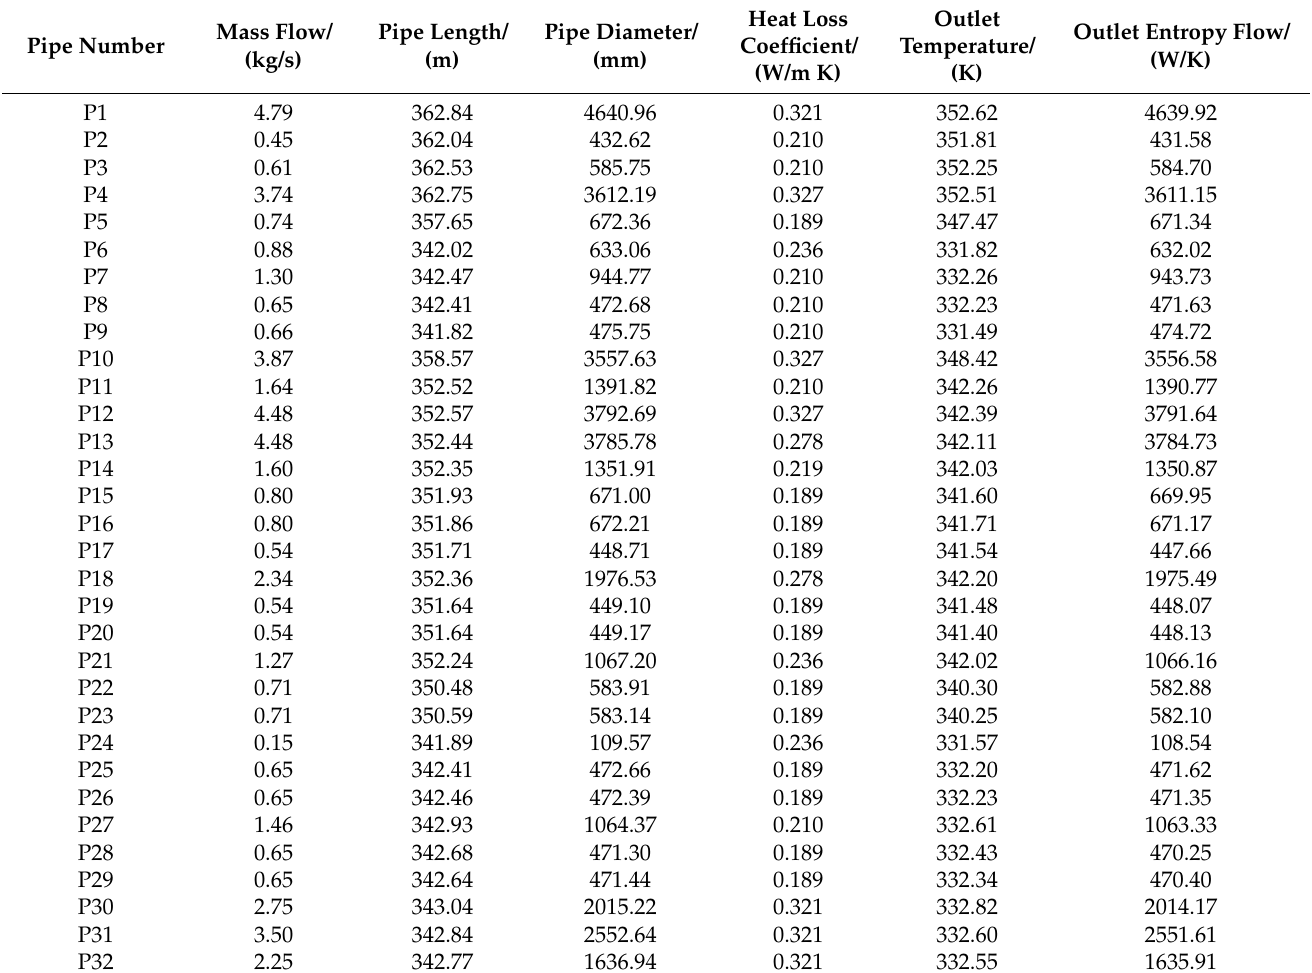
Table 1. Pipe parameters and calculation results of each branch in Case